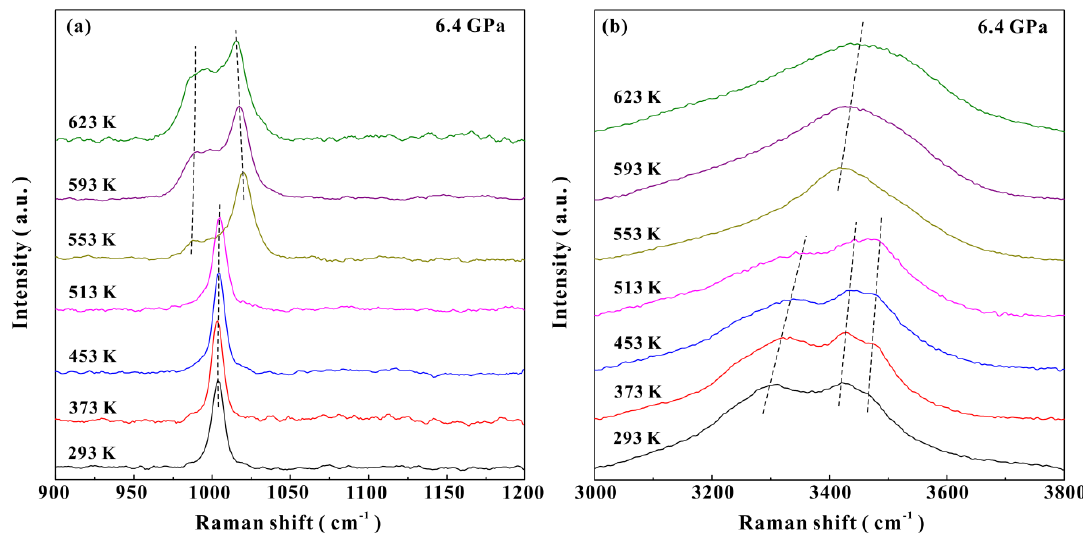
Figure 5. (a) The Raman spectra of the epsomite at 293–623 K and ~6.4 GPa in the sulfate vibrational range; ( b ) the collected high ‐ temperature Raman spectra of the epsomite at ~6.4 GPa in the hydroxyl ‐ stretching vibrational range.